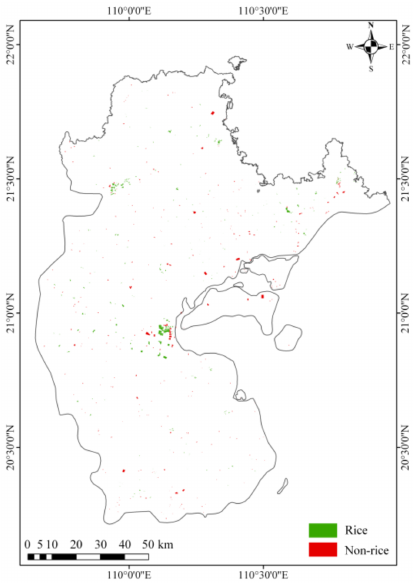
Figure 9. Sample data